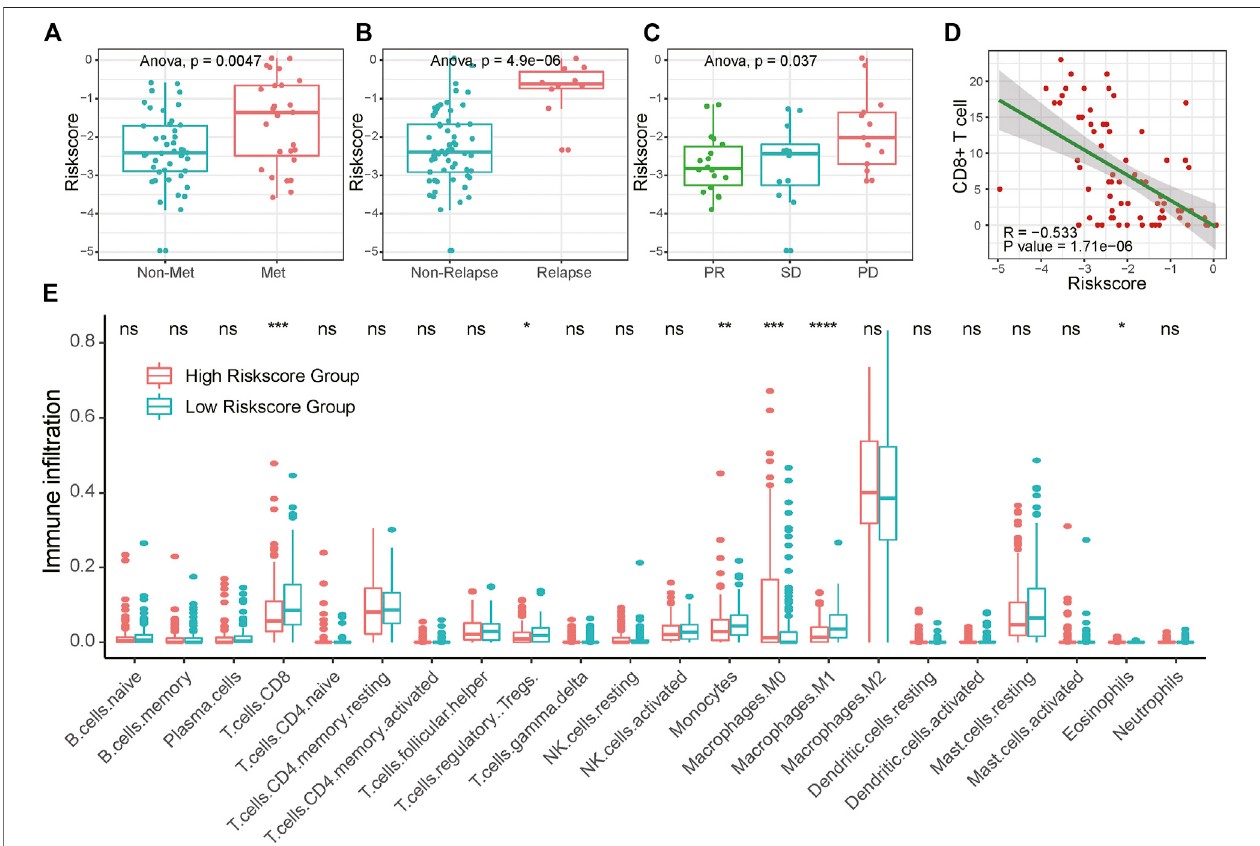
FIGURE 6| Association ofRA risk score and sarcoma prognostic indicators. (A – B) Lung metastasis and local recurrence sarcoma patientshad higher risk scores thanthosewithouttumordisseminationoruntreatedtumor. (C) Sarcomapatientswithunfavorableneoadjuvantchemotherapyresponseslinktothehigherriskscore (D) CD8 + T cell in fi ltration negatively correlated with the RA risk score (E) The fractions of immune cells between high-risk score and low-risk score samples in TCGA database by using CIBERSORT. PD, progressive disease; PR, partial response; SD, stable disease.